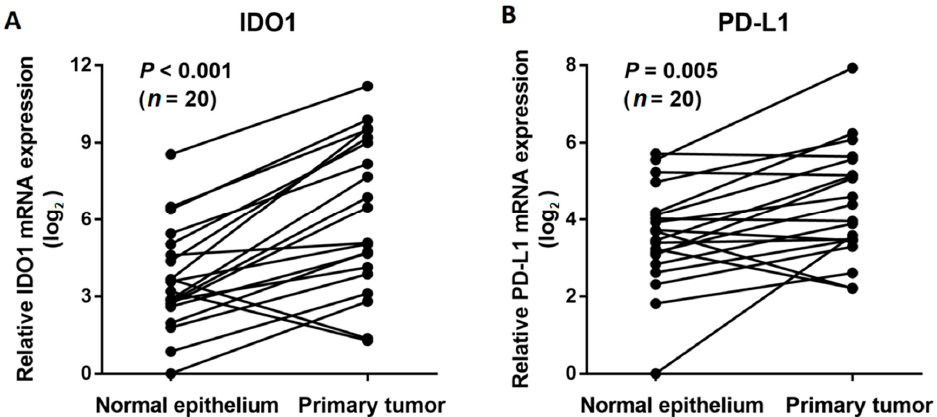
Figure 1. Comparison of indoleamine 2,3-dioxygenase 1 (IDO1) ( A ) and programmed cell death-ligand 1 (PD-L1) ( B ) mRNA expression levels in esophageal squamous cell carcinoma tissues and matched normal esophageal mucosa by qRT-PCR.